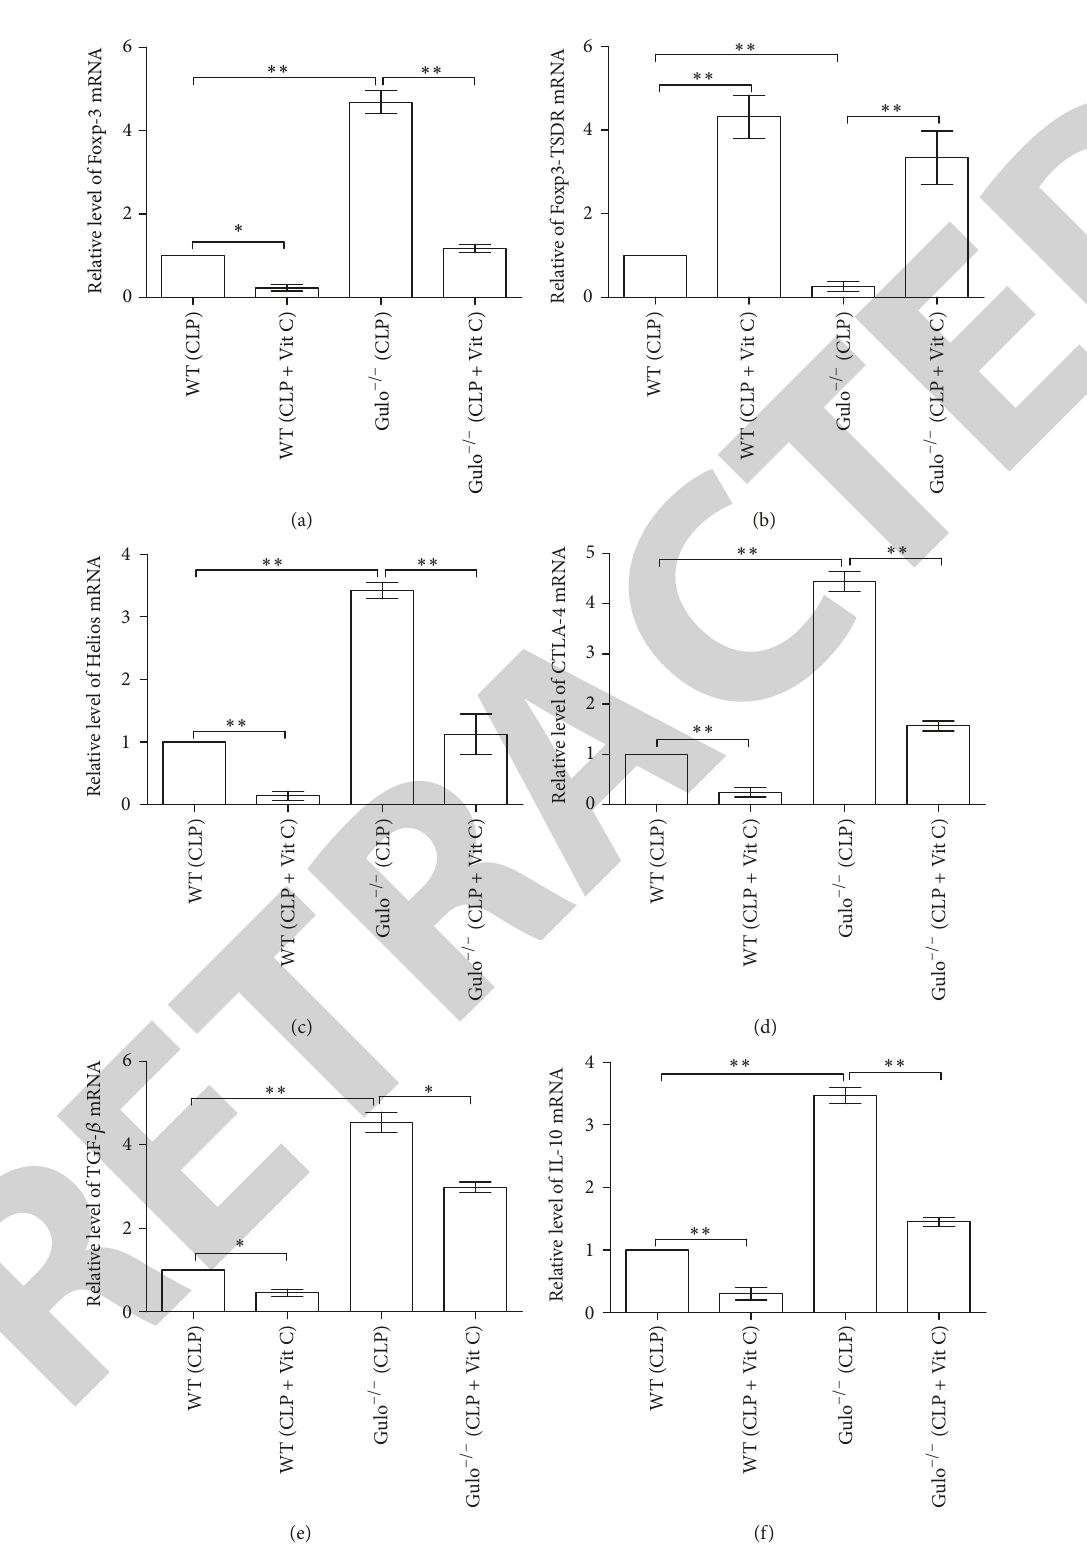
Figure 4: The impact of parenteral Vit C on the mRNA expression of Foxp-3, Helios, CTLA-4, TGF- 𝛽 , IL-10, and the methylation level of Foxp3-TSDR mRNA in CD4 + CD25 + Tregs; CD4 + CD25 + Tregs were harvested for SYBR Green and Methylation-Sensitive RT-PCRT from every group after CLP. The parenteral Vit C inhibited the expression of Foxp-3 (a), Helios (c), CTLA-4 (d), TGF- 𝛽 (e), and IL-10 (f) but increased the methylation level of Foxp3-TSDR (b) in CD4 + CD25 + Tregs. Data were represented as mean ± standard deviation (SD) and analyzed by software SPSS 17.0 with one-way ANOVA, 𝑛 = 4 per group, ∗ 𝑝 < 0.05 or ∗∗ 𝑝 < 0.01